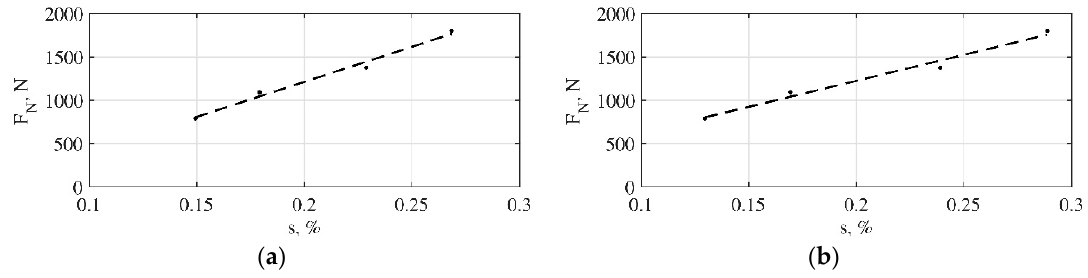
Figure 14. Load dependence as a slip function for ( a ) left wheel; ( b ) right wheel.